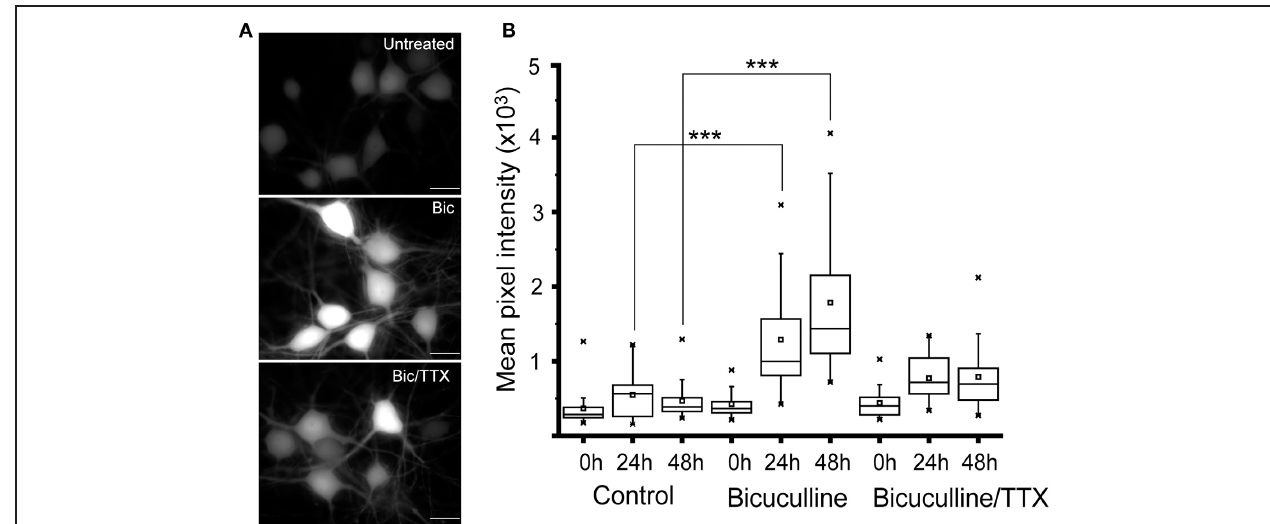
FIGURE 2 | Suppressing inhibitory activity markedly increases Cycs enhancer-driven GFP expression. (A) Hippocampal neurons were exposed to bicuculline (20 μ M) or bicuculline plus TTX (1 μ M) for 48h. Images of living neurons, normalized to the same intensity scale, show marked differences in GFP levels between treatments. Scale bar corresponds to 20 microns.